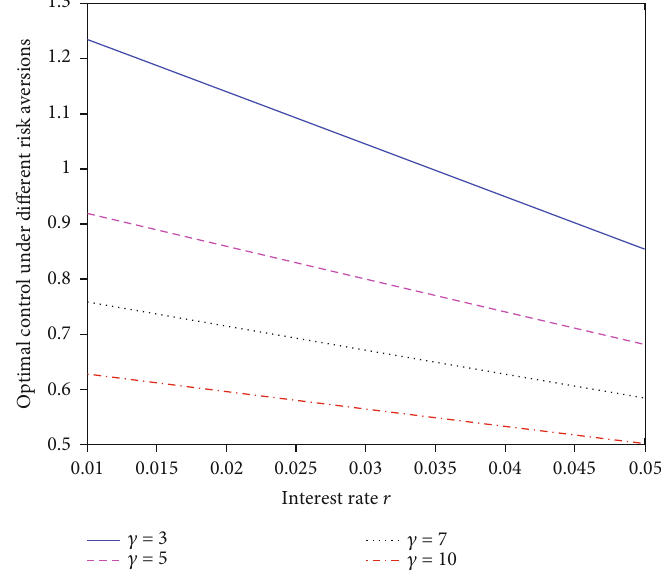
Figure 2: The relationship between u ∗ and r under di ff erent γ